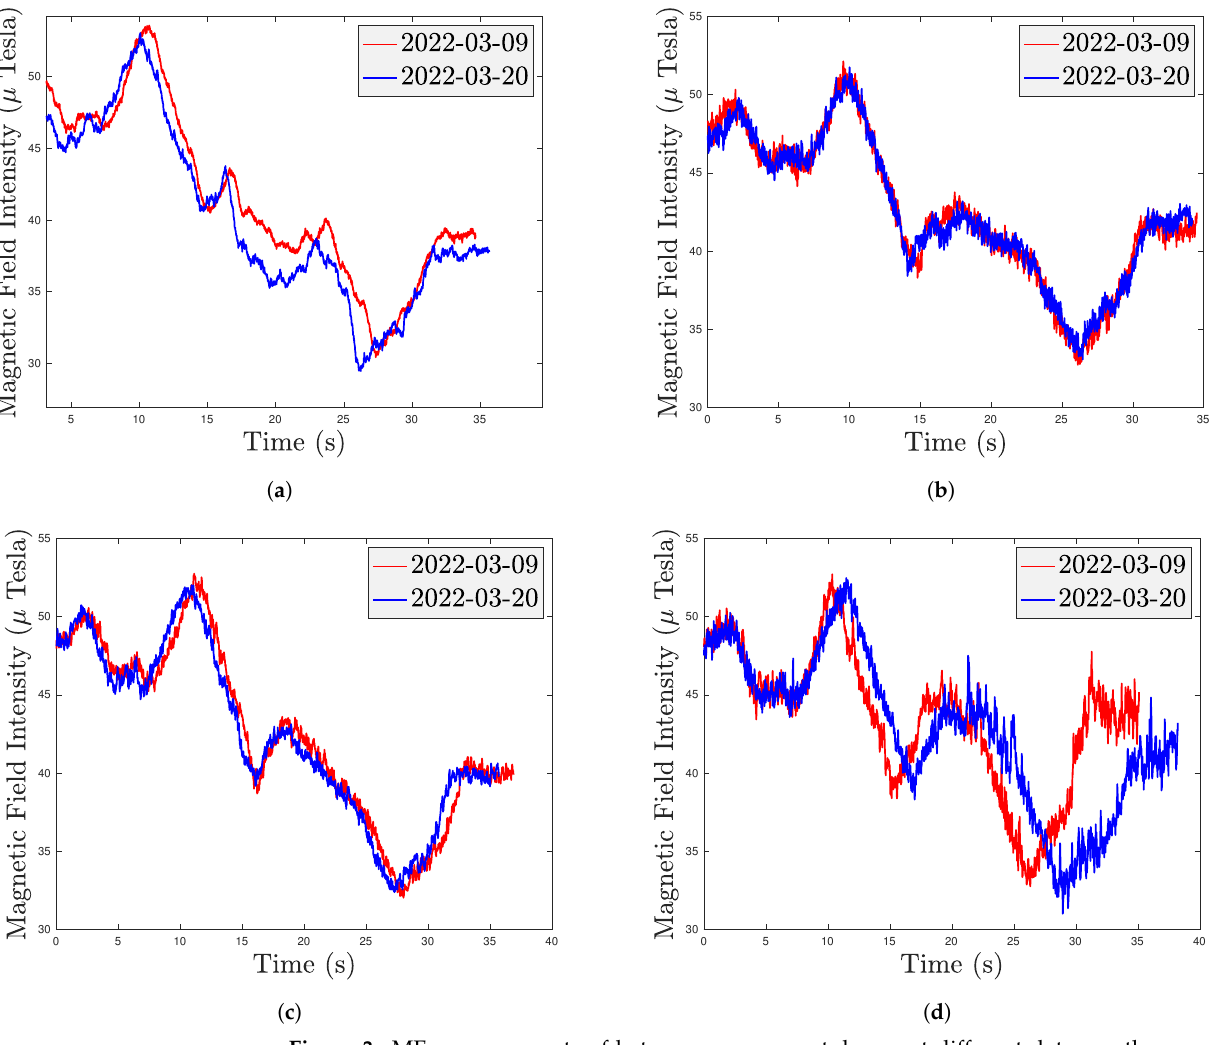
Figure 3. MF measurements of heterogeneous smartphones at different dates on the same path. ( a ) iPhone Xs Max; ( b ) Samsung S9; ( c ) Redmi Note 10 Pro; ( d ) Huawei